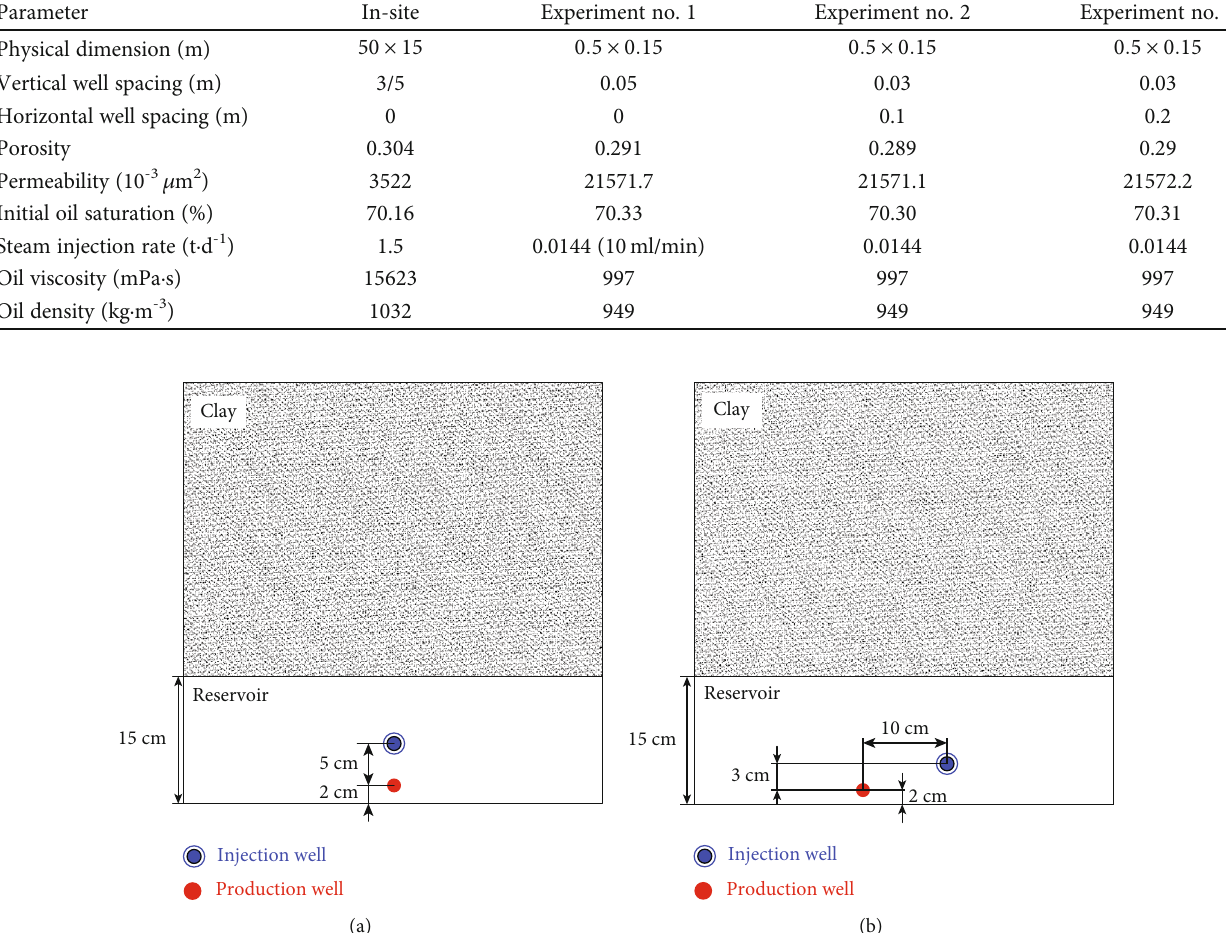
Table 1: Parameters of 2D experiment.